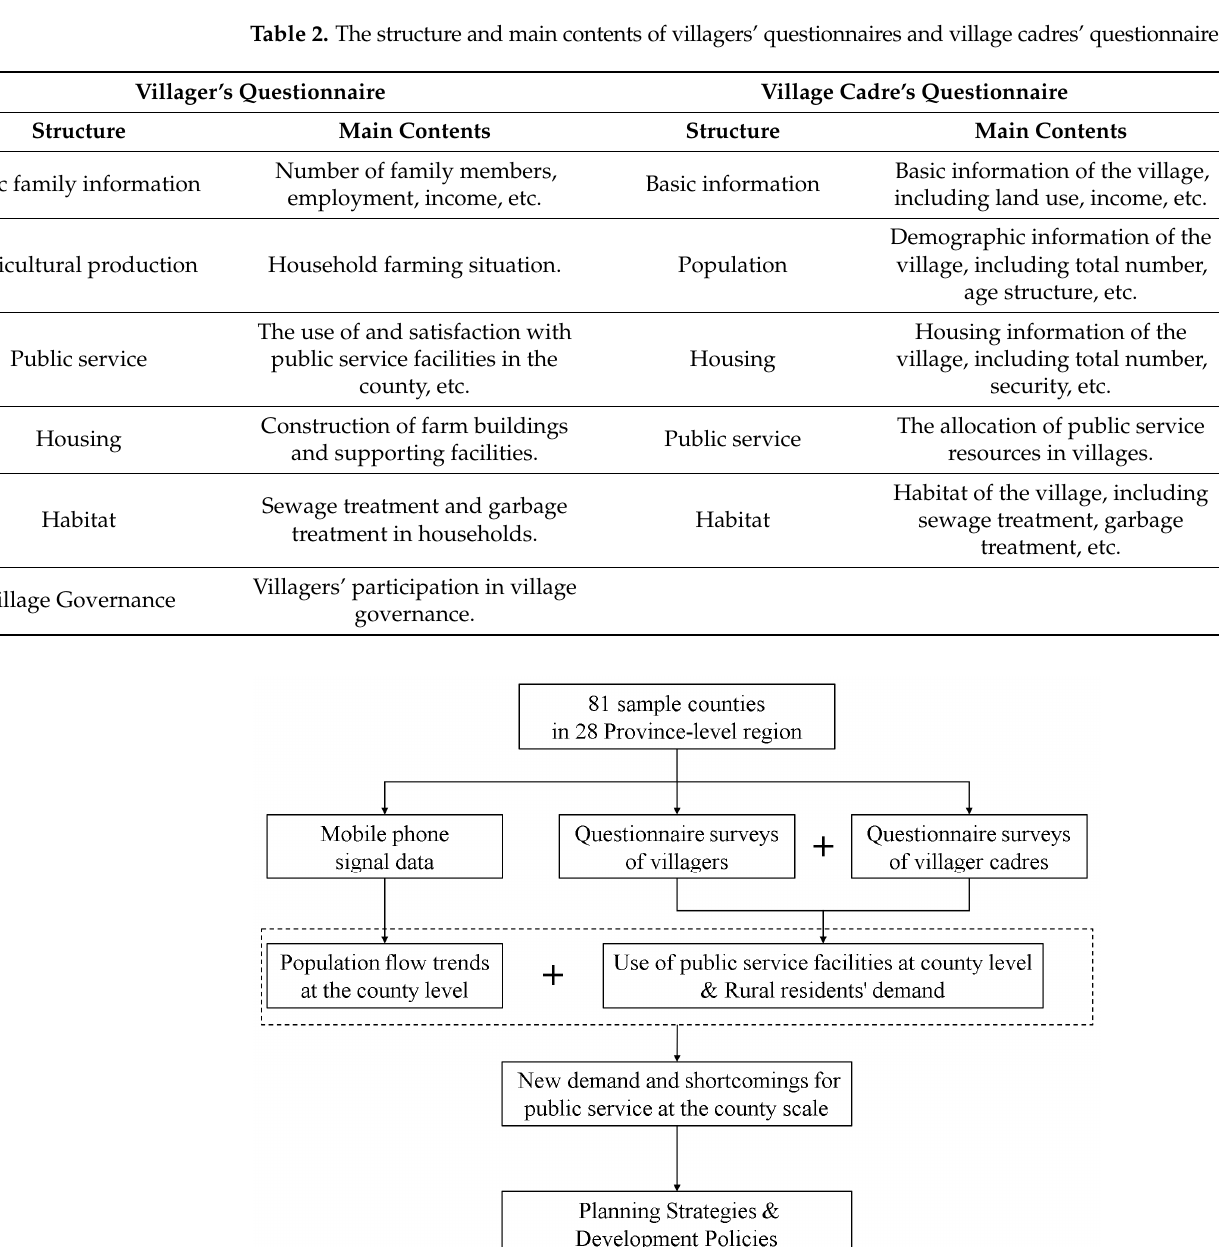
Table 2. The structure and main contents of villagers’ questionnaires and village cadres’ questionnaires.